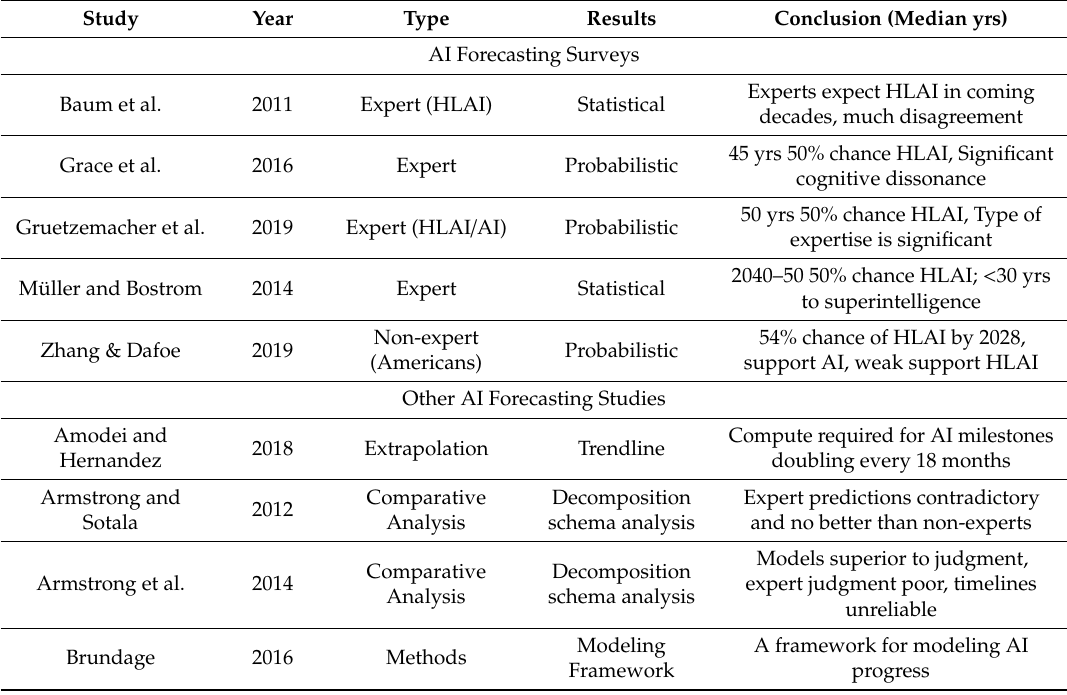
Table 1. A comparison of surveys and alternative studies previously conducted on AI forecasting. Study Year